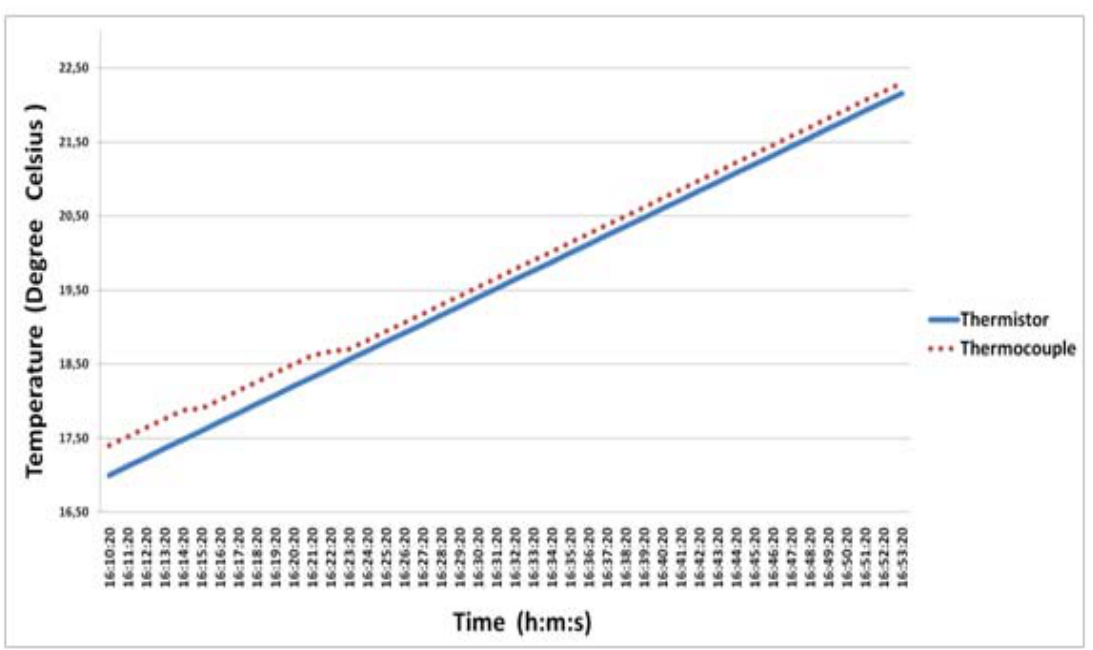
Figure 7. Performance comparison between temperature values acquired with a thermopar and a thermistor inside a glass of water.